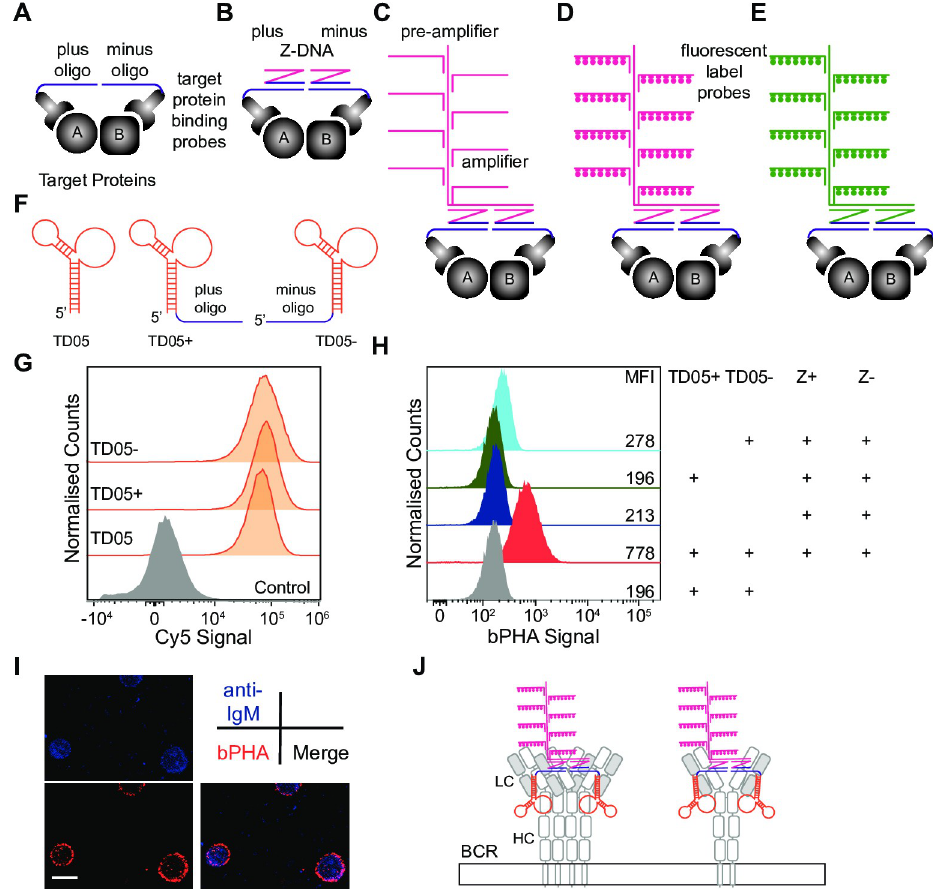
Fig 1. The bPHA specifically detects the proximal localization of BCRs on Ramos cell surface. (A-D) Schematic presentation of bPHA. The proximity of protein A and protein B is converted to the proximity of plus and minus oligos. The oligos are then hybridized to Z-DNA, followed by preamplifier, amplifier, and finally, fluorescent label probes. (E) Diagram showing that changing a part of the Z-DNA allows the change of fluorescence of bPHA signal. (F) Schematic presentation of TD05 aptamer and the TD05 − and TD05+ derivatives. (G) Flow cytometry results showing similar staining of Ramos cells with Cy5-labeled TD05, TD05+, and TD05 − . Cells stained with Cy5-coupled unrelated aptamer functioned as negative control. (H) TD05+:TD05 − bPHA signal measured by flow cytometry for Ramos cells treated with the indicated probes. (I) Confocal microscopic images of Ramos cells after bPHA and anti-IgM staining. (G-I) Data represent at least three independent experiments. (J) Schematic drawing explaining what could be measured by the TD05+:TD05 − bPHA. BCR, B cell antigen receptor; bPHA, branched proximity hybridization assay; Cy5, cyanine 5; HC, heavy chain; IgM, immunoglobulin M; LC, light chain; MFI, mean fluorescence intensity.